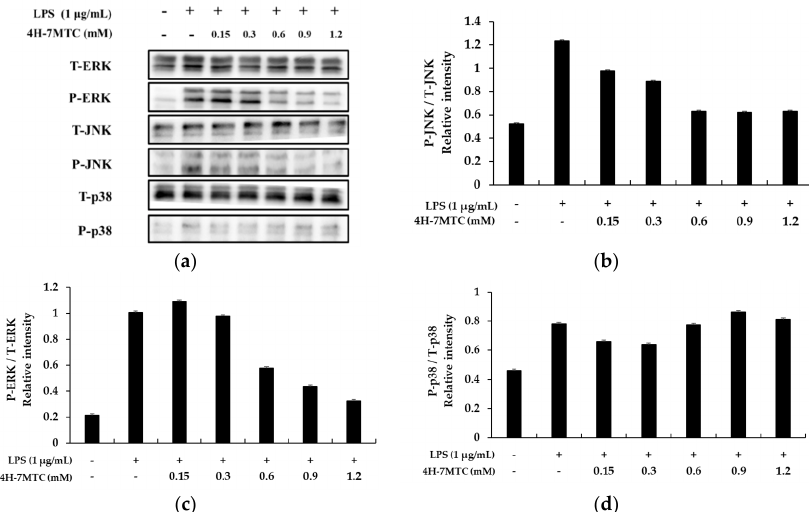
Figure 6. Effect of 4-hydroxy-7-methoxycoumarin (4H-7MTC) on the level of phospho-I κ B- α and I κ B- α in LPS-induced RAW264.7 cells. Lysates were prepared from cells pretreated with 4H-7MTC (0.15, 0.3, 0.6, 0.9, and 1.2 mM) for 1 h and then treated with LPS (1 μ g/mL) for 20 min. Western blotting was performed to detect the expression of I κ B α and p-I κ B α . β -actin was used as a loading control ( a ). Quantification of immunoreactive protein bands is shown via bar graphs ( b , c ).